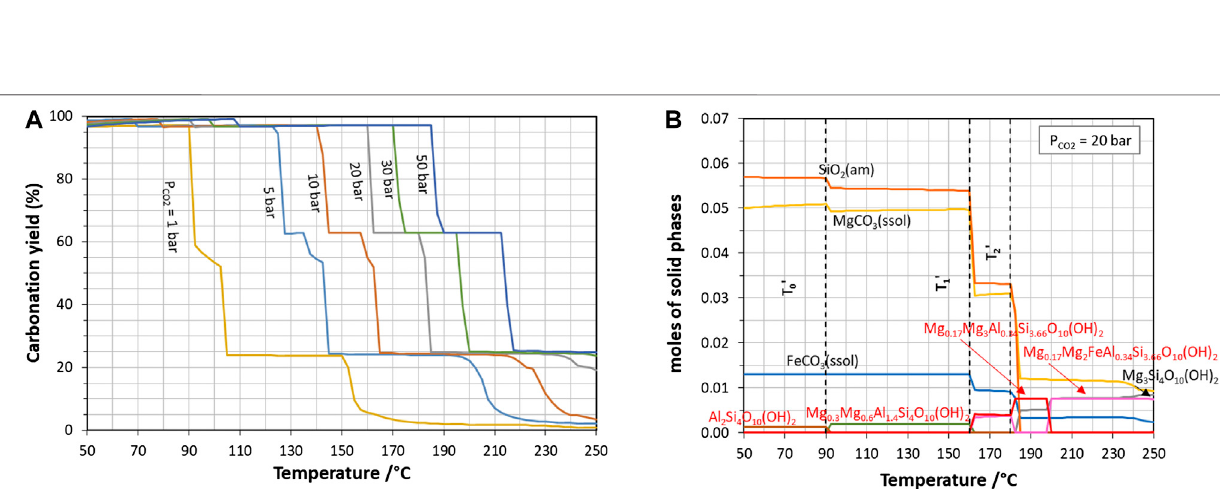
Frontiers in Chemical Engineering |